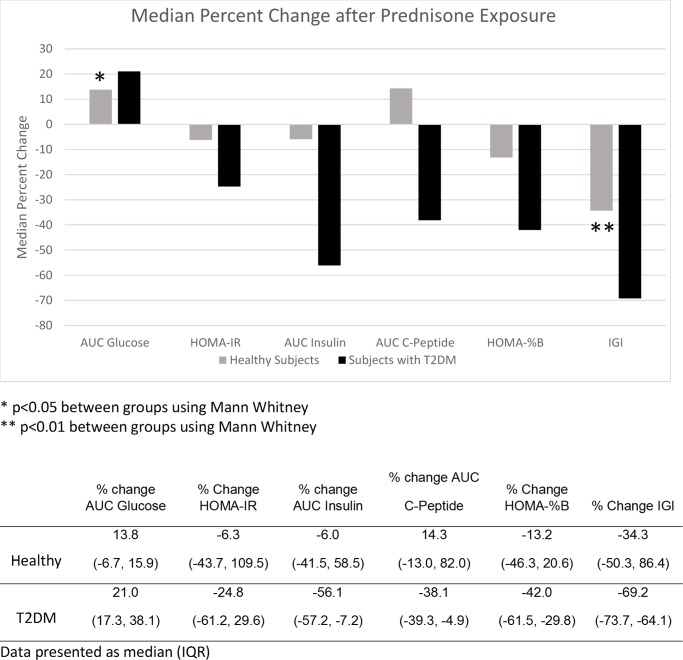
Comparisons of median percent changes of glycemic and beta cell parameters from baseline to after prednisone exposure between the healthy and T2DM groups.